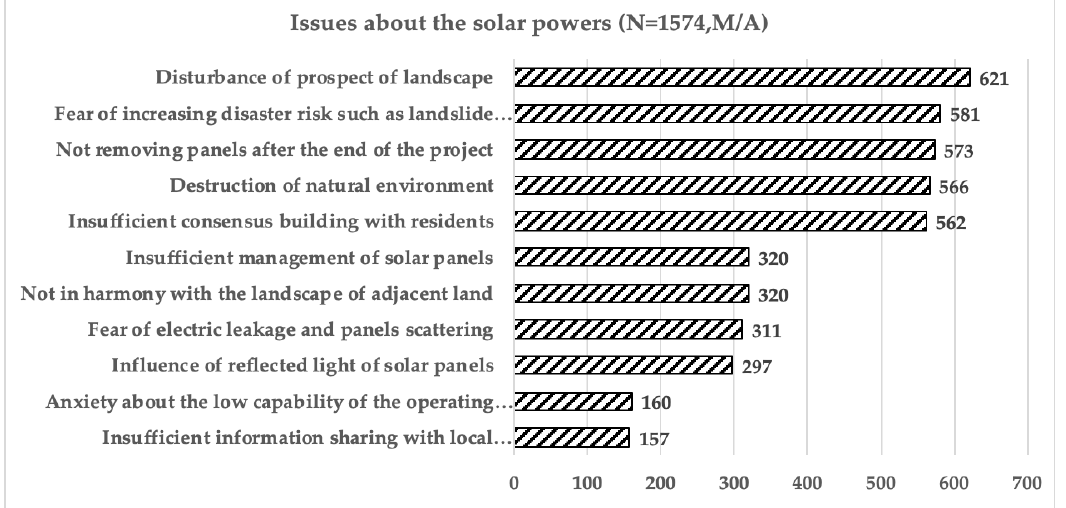
Figure 4. Items recognized by local governments to be regulated. Source: Own survey data.